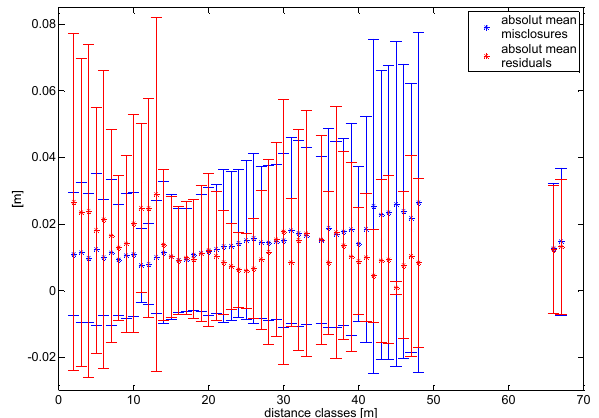
Figure 8: Residuals of distance and misclosures depending on the distances with a binning of 1 m. Only distance classes with at least 500 points are